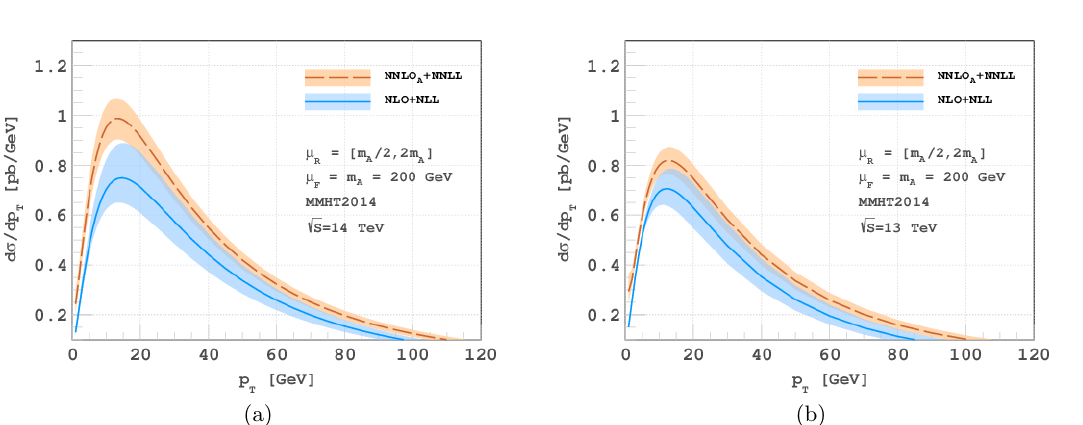
Figure 4 . Variation of (cid:22) R at NLO+NLL and NNLO A +NNLL keeping (cid:22) F (cid:12)xed at m A for (a) 14 TeV and (b) 13